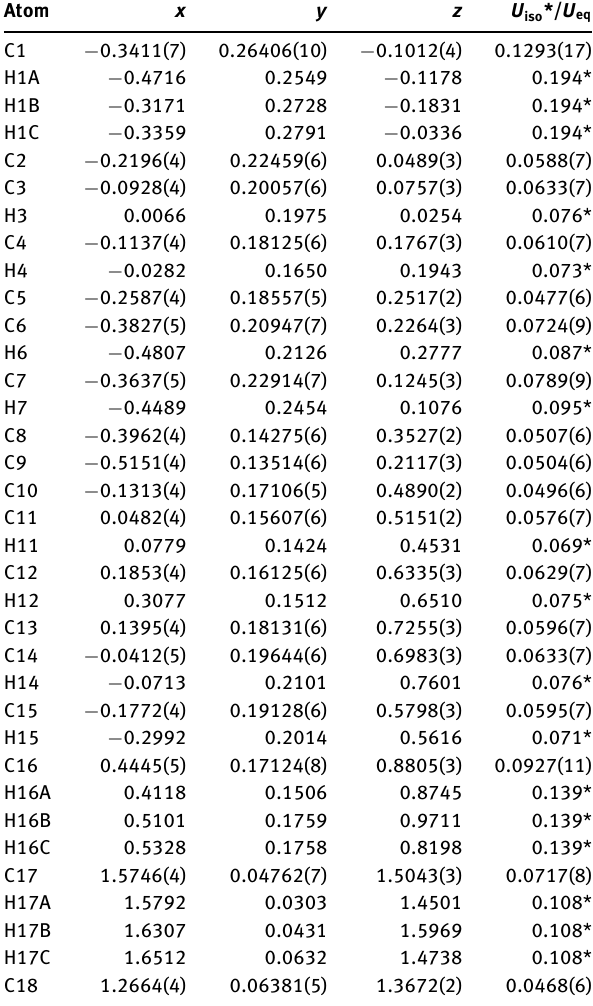
Table 2: Fractional atomic coordinates and isotropic or equivalent isotropic displacement parameters (Å 2